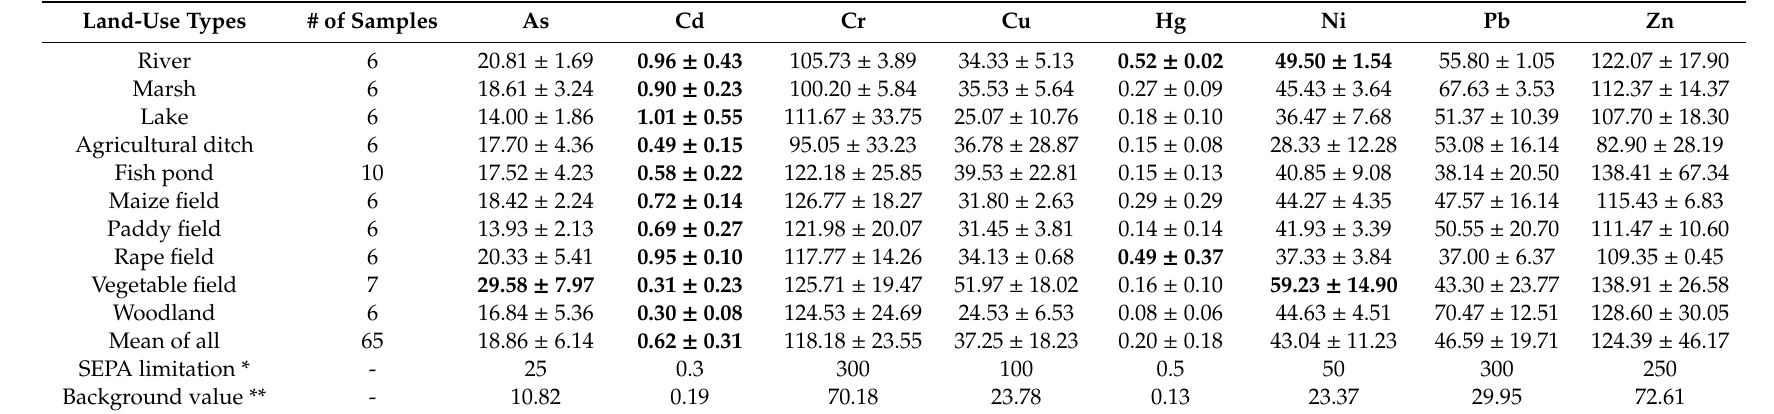
Table 1. Heavy metal concentrations (mg / kg in dry weight) in samples taken from di ff erent landuse types of the